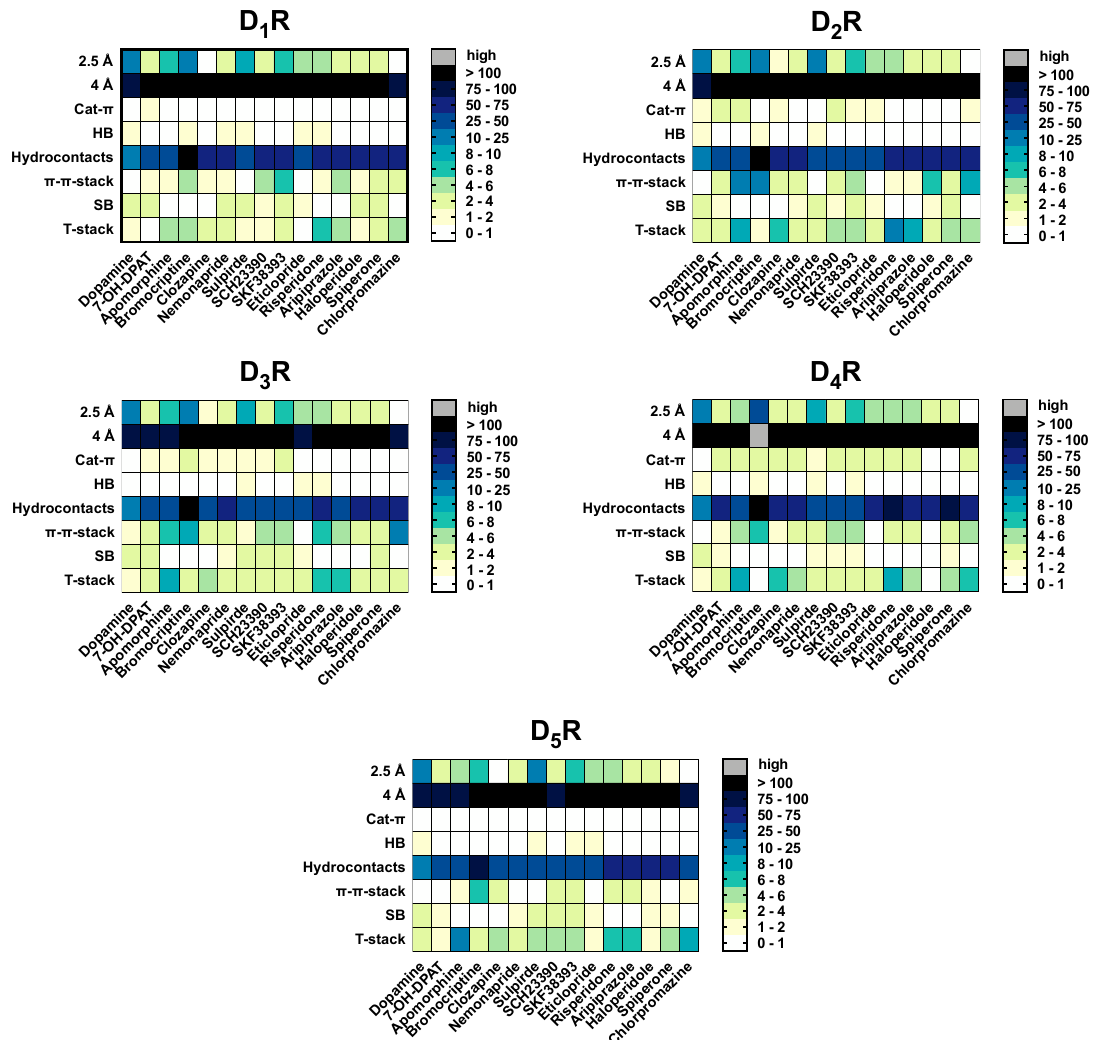
Figure 6. Interaction types counted for each ligand at DR-subtypes. Data are summarized for each ligand at all time points. Total numbers of the contacts for each interaction type are color-coded: few interactions were colored white, while many interactions were colored dark. Grey cells indicate that these values are outside the scale, which was only the case for bromocriptine at the D 4 R with 360 four Å-interactions.